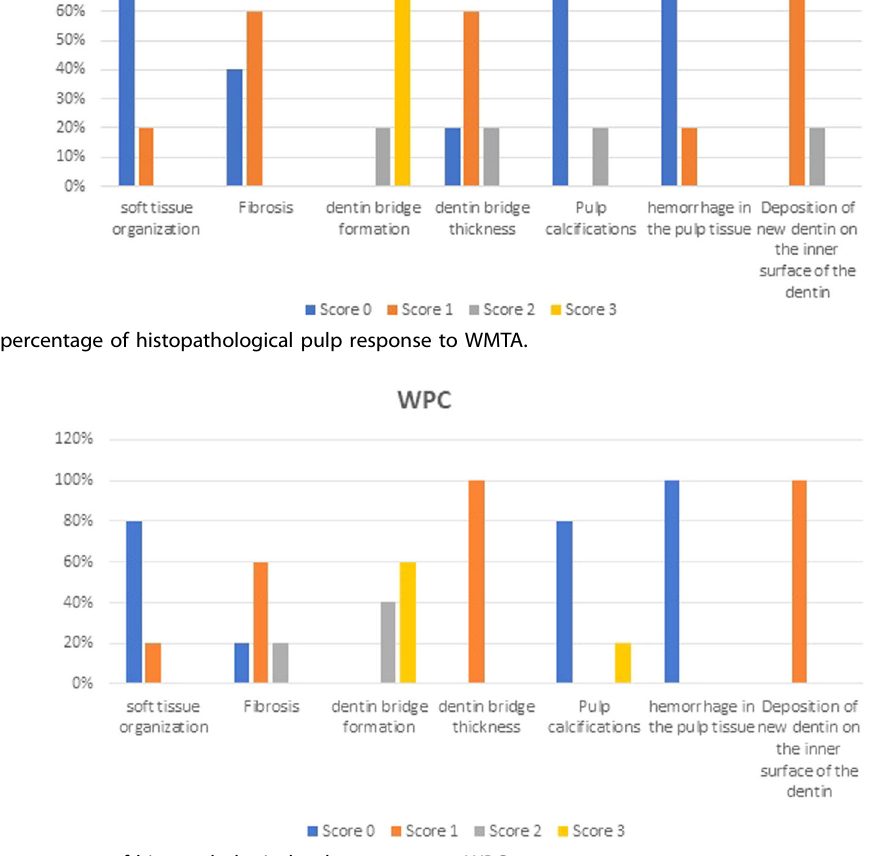
Fig. 7 The average percentage of histopathological pulp response to